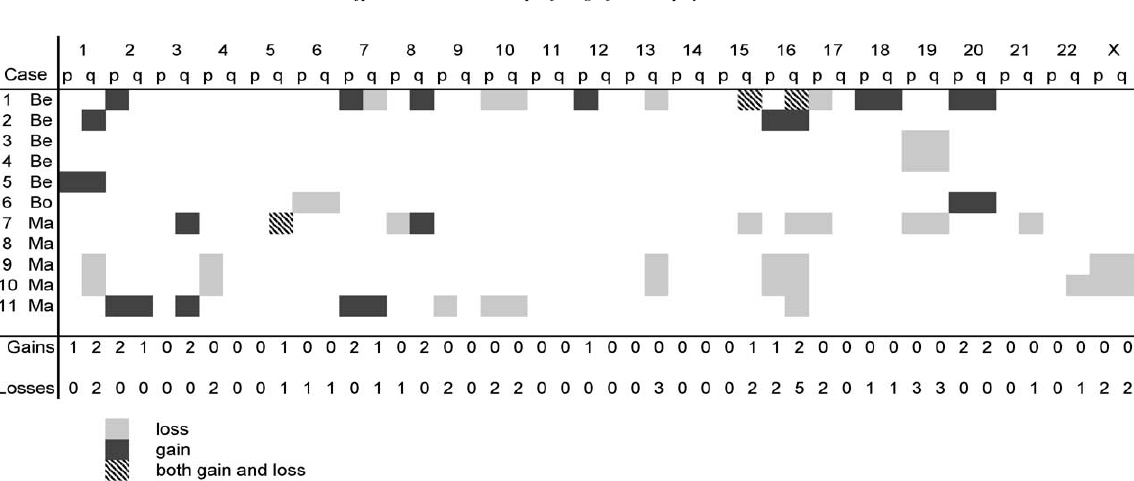
Fig. 1. Schematic overview of affected chromosomal regions in 11 phyllodes tumours of the breast. Amplifications are not shown here. Be: benign grade phyllodes tumour; Bo: borderline; Ma: malignant.